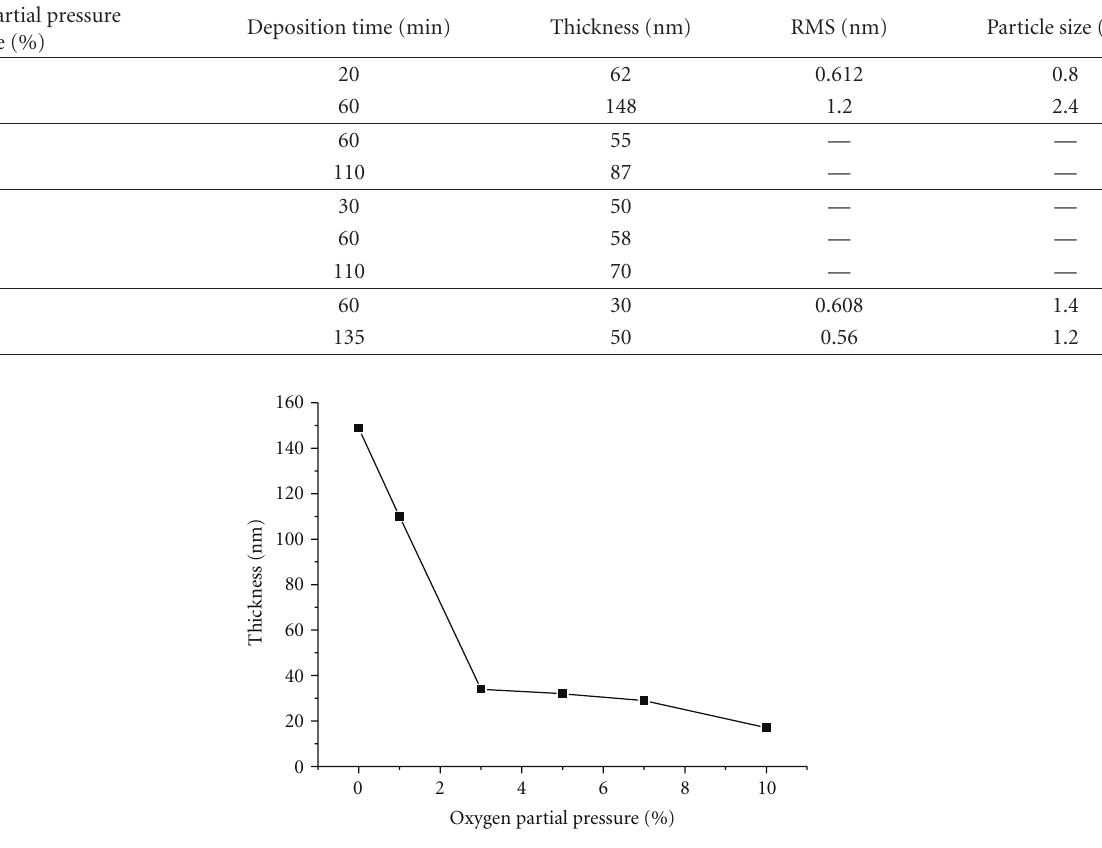
Figure 1: Thickness of SnO 2 films as a function of the oxygen partial